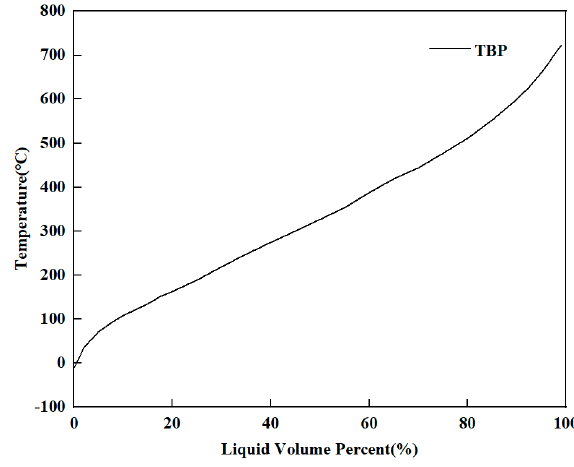
Figure 4. True boiling point distillation curve of crude oil.